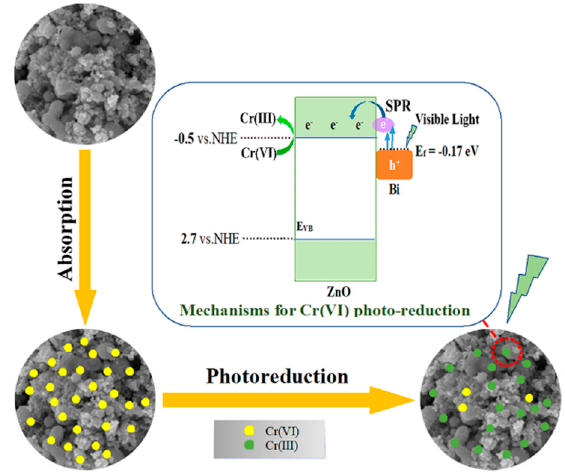
Figure 9. Mechanism for Cr(VI) removal catalyzed by BiNPs/ZnO nanocomposites under visible light irradiation.